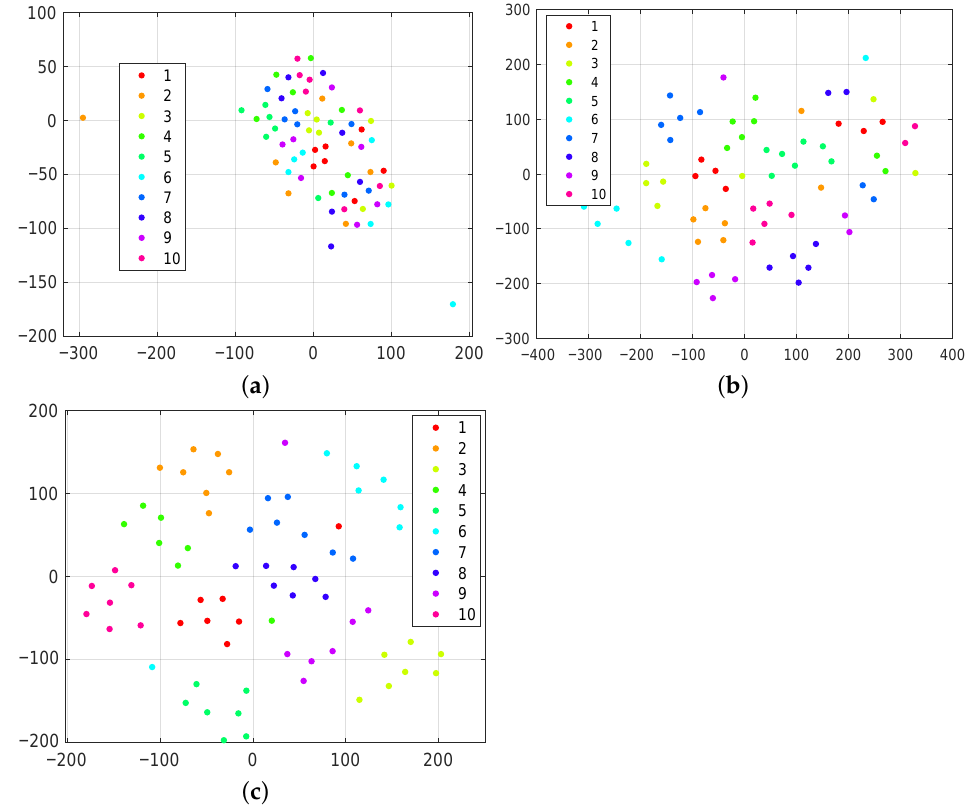
Figure 3. t-SNE visualization of ( a ) original data, ( b ) the first-order IGO with the mapping defined in Equation (4), and ( c ) the SOIGO with the mapping defined in Equation (4); each color represents a class. For better visualization, please refer to the electronic version of this